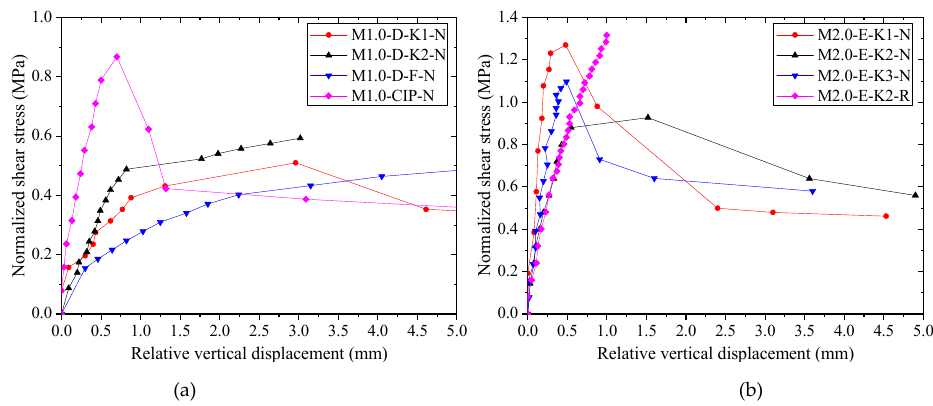
Figure 9. Normalized average shear stress-relative vertical displacement relationships of specimens expressed by dry and epoxied specimens, respectively: ( a ) dry and cast-in-place specimens with confining stress of 1.0 MPa; ( b ) specimens with epoxy resin and with confining stress of 2.0 MPa.